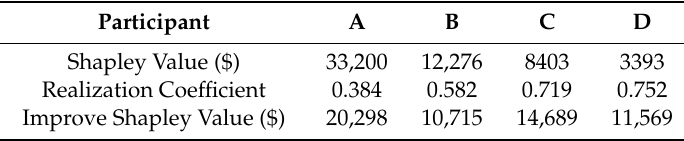
Table 6. Allocation Result in Outer Layer.